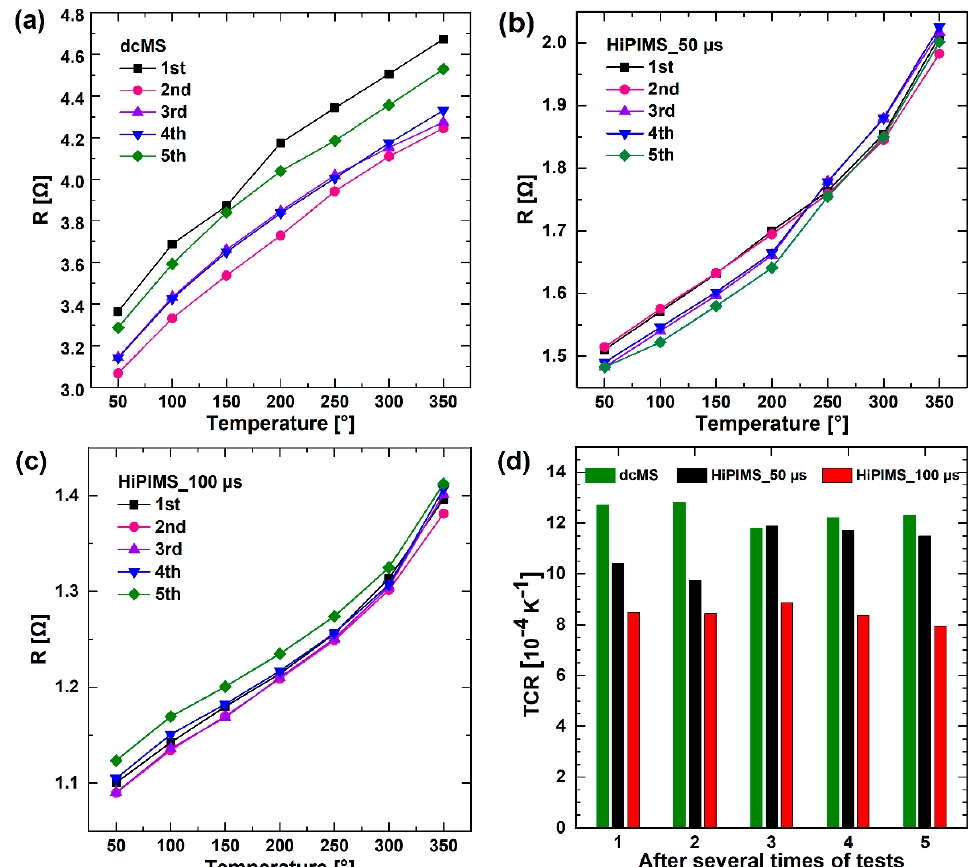
Figure 12. Thermal resistance test results of W thin films after vacuum annealing at 400 °C for 1 h. ( a ) Electrical resistivity of ( a ) dcMS, ( b ) 50 μ s-pulse-length-HiPIMS, and ( c ) 100 μ s-pulse-length- HiPIMS prepared W thin films with respect to temperature and test numbers, ( b ) electrical resistivity of dcMS-W thin film with respect to temperature and test numbers. ( d ) TCR values of W thin films prepared by dcMS and HiPIMS after vacuum annealing at 400 °C for 1 h.